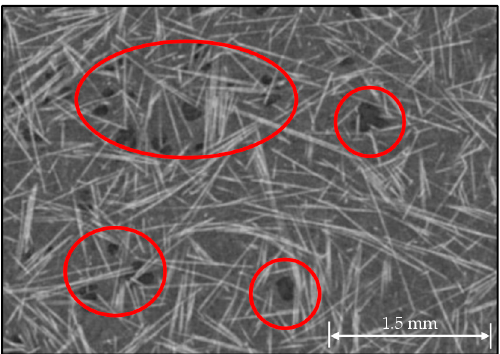
Figure 17. μ CT image from spattered voids in Bluestone tool specimens for a nominal fiber content and 60 wt.%.